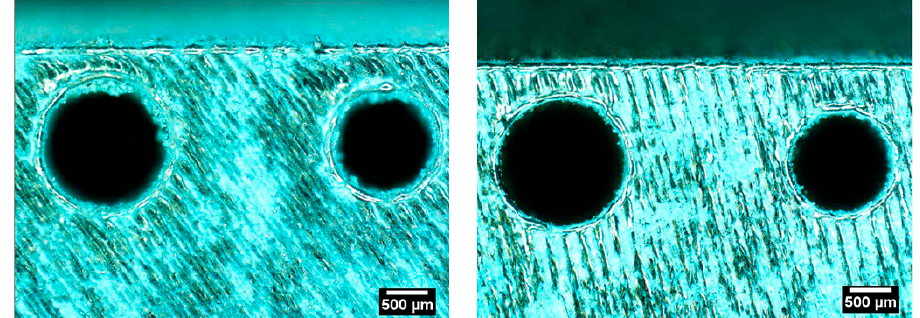
Figure 22. Optical microscope pictures of selected holes: diameter of 1.5 mm and 1.2 mm, F, first job, central sample ( left ); diameter of 1.5 mm and 1.2 mm, H, first job, central sample ( right ).